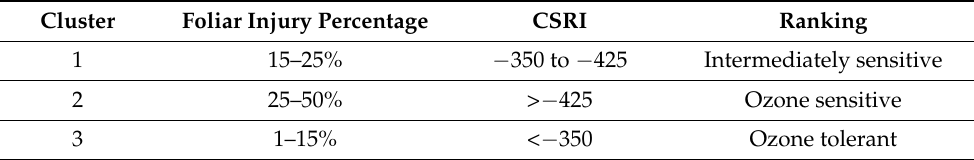
Figure 9. Dendrogram grouping of eight tomato cultivars based on foliar injury percentage, cumulative stress response index, and yield. Table 3. Categorization of tomato cultivars based on cluster